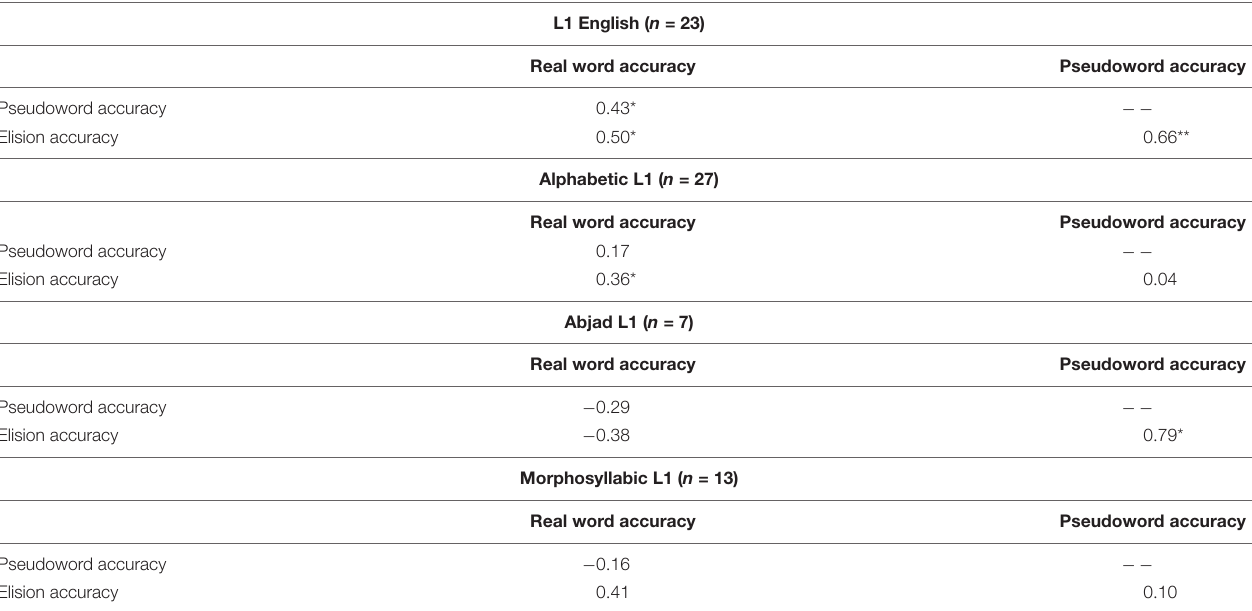
TABLE 2 | Correlations among spelling and phonological awareness accuracy by L1